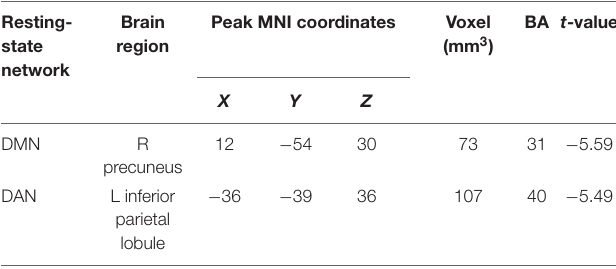
TABLE 2 | Abnormal functional connectivity in the patients with T2DM compared to the HC